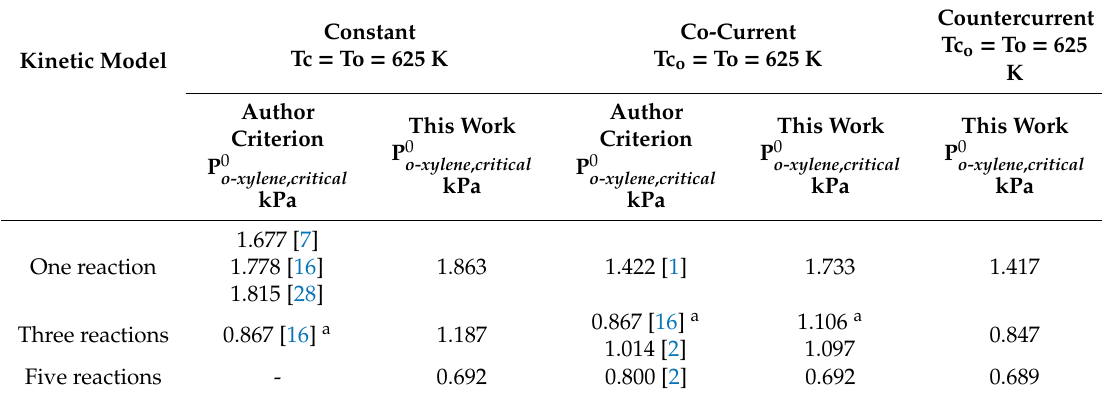
Table 4. Critical feed pressures at di ff erent service fluid configurations. Comparison between di ff erent criteria obtained from di ff erent kinetic